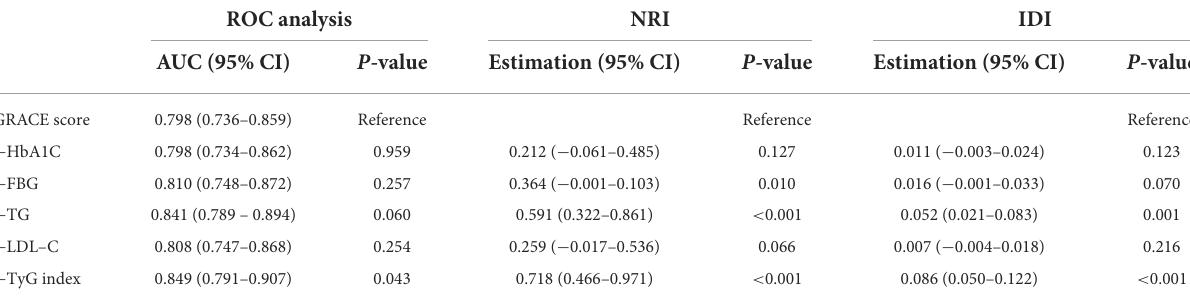
TABLE 3 Prognostic predictive value of GRACE score when combined with other